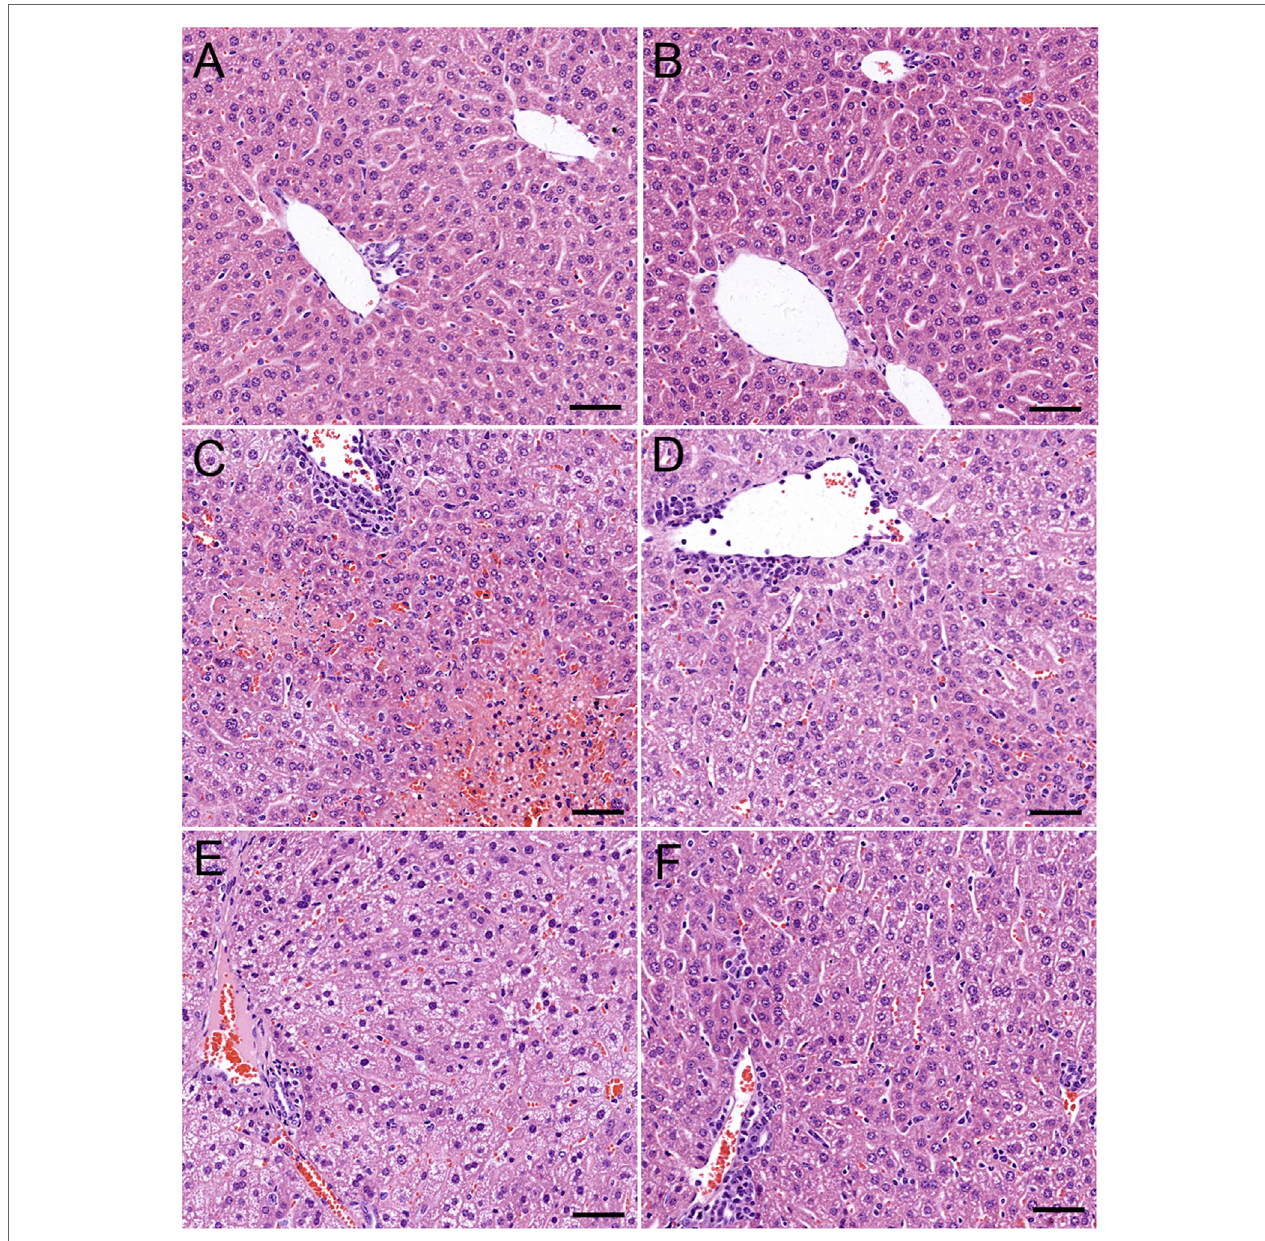
FigUre 5 | The protective effects of ARC on liver pathology of ConA-induced hepatitis mice. ARC or vehicle alone had no effects on morphology of liver section (a,B) . Serious liver damage was found in model group at 12 h after ConA (10 mg ⋅ kg − 1 ) administration (c) . Portal inflammation, hepatocytes edema, severe congestion in hepatic sinusoid around central veins, and focal or confluent necrosis occurred significantly. ARC significantly inhibited ConA-induced histological changes, which was comparable with effects of CSA and PS (D–F)